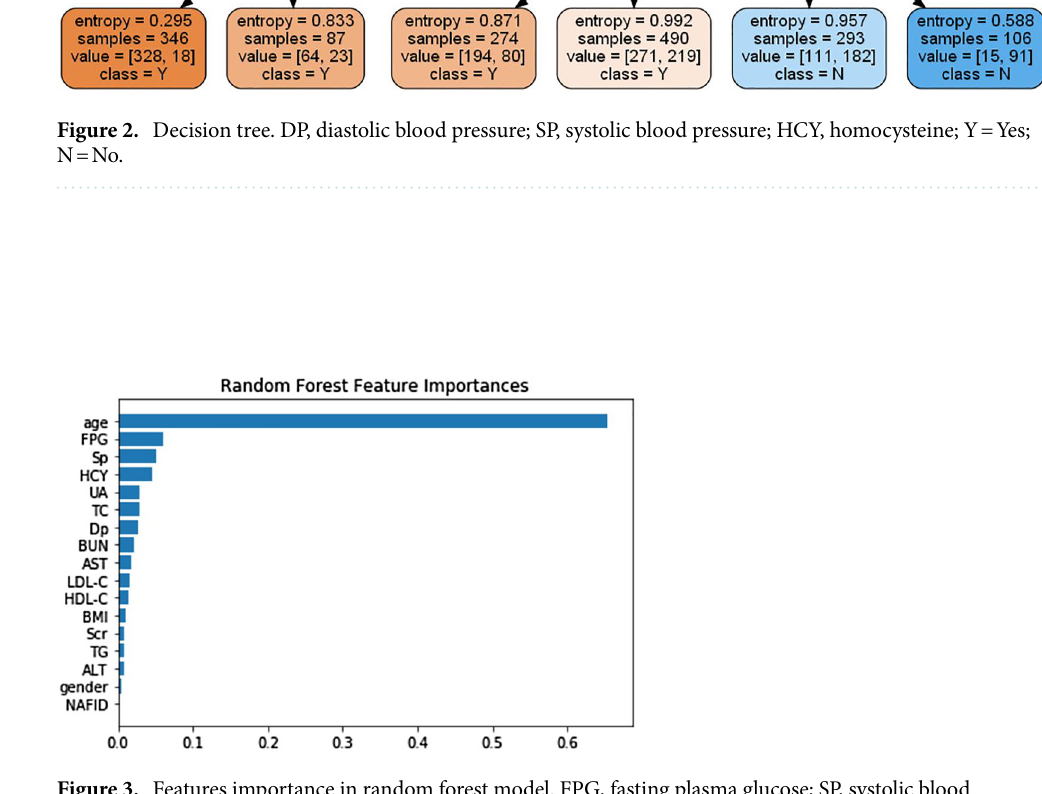
Figure 3. Features importance in random forest model. FPG, fasting plasma glucose; SP, systolic blood pressure; HCY, homocysteine; UA, blood uric acid; TC, total cholesterol; DP, diastolic blood pressure; BUN, blood urea nitrogen; AST, serum aspartate aminotransferase; LDL-C, low-density lipoprotein cholesterol; HDL- C, high-density lipoprotein cholesterol; BMI, body mass index; Scr, serum creatinine; TG, triglyceride; ALT, serum alanine aminotransferase; NAFLD, nonalcoholic fatty liver